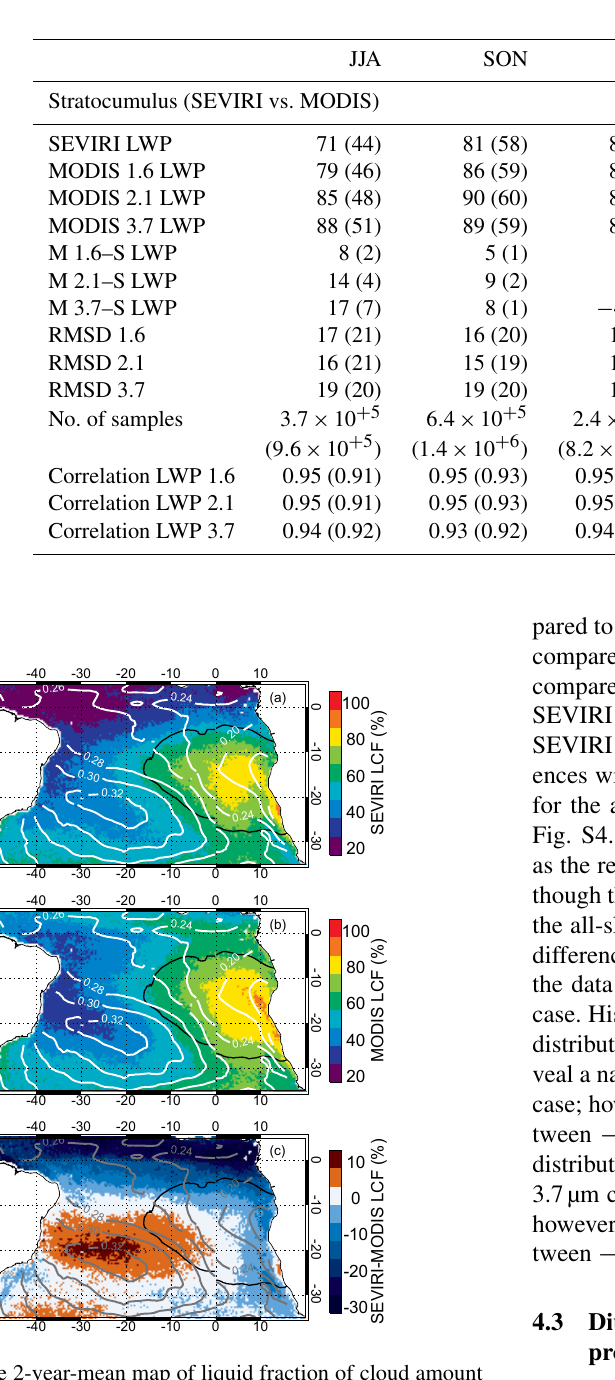
Table 2. The 2-year-mean and seasonal statistics of collocated SEVIRI and MODIS retrievals in rain-free, ice-free, smoke-free (AI < 0 . 1), τ > 3, and overcast (LCF ≥ 95%) grid cells over the marine stratocumulus region. LWP means, biases (MODIS-SEVIRI), and root mean square deviations (RMSDs) are given in gm − 2 . Corresponding τ means and r e means (in µm) are tabulated in Table S1. The values in brackets are statistics without filtering for LCF ≥ 95% and τ > 3, i.e., for the all-sky case. The “S” and “M” labels refer to SEVIRI and MODIS.